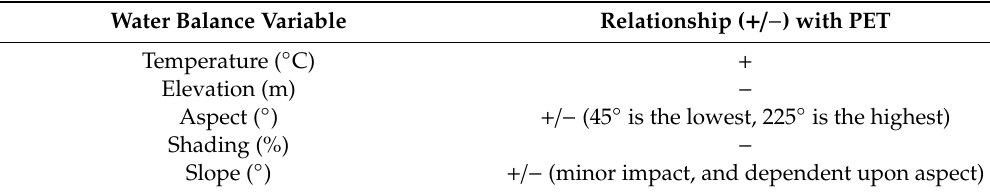
Table 3. Potential evapotranspiration water balance model modifiers.